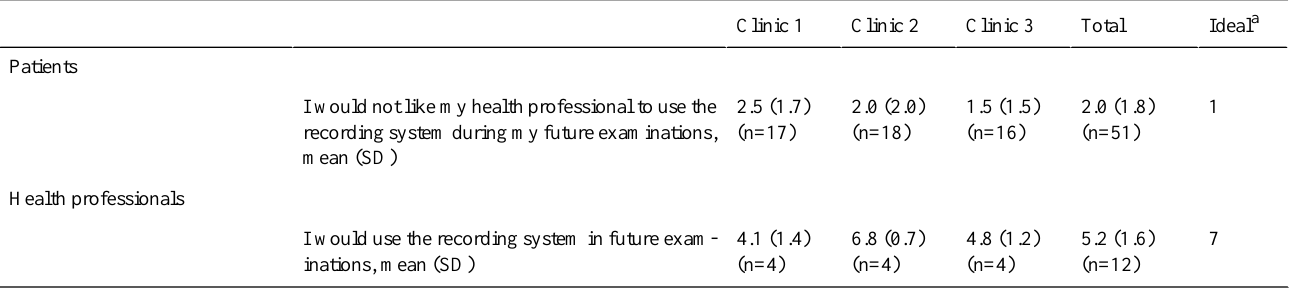
Table 7. Questionnaire data for acceptability metric (future use).